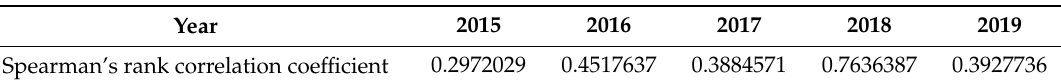
Table 2. Spearman’s rank correlation coe ffi cient between the number of years with human WNND cases (0–5) and the number of human cases for each year.